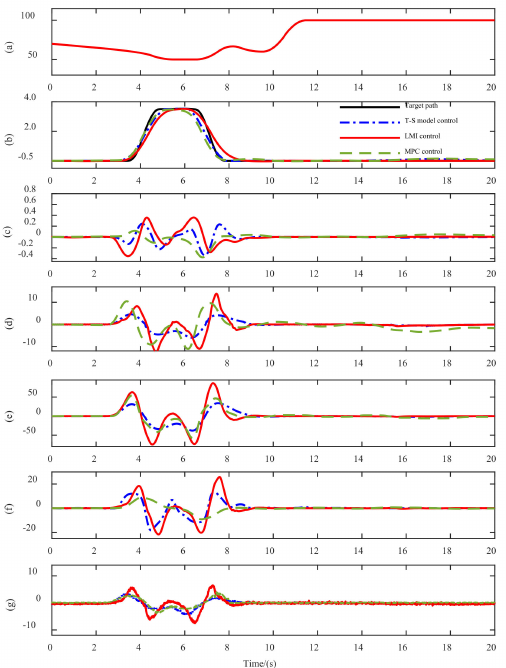
Figure 7. ( a ) Speed (km/h), ( b ) lateral displacement (m), ( c ) deviation (m), ( d ) steering torque control